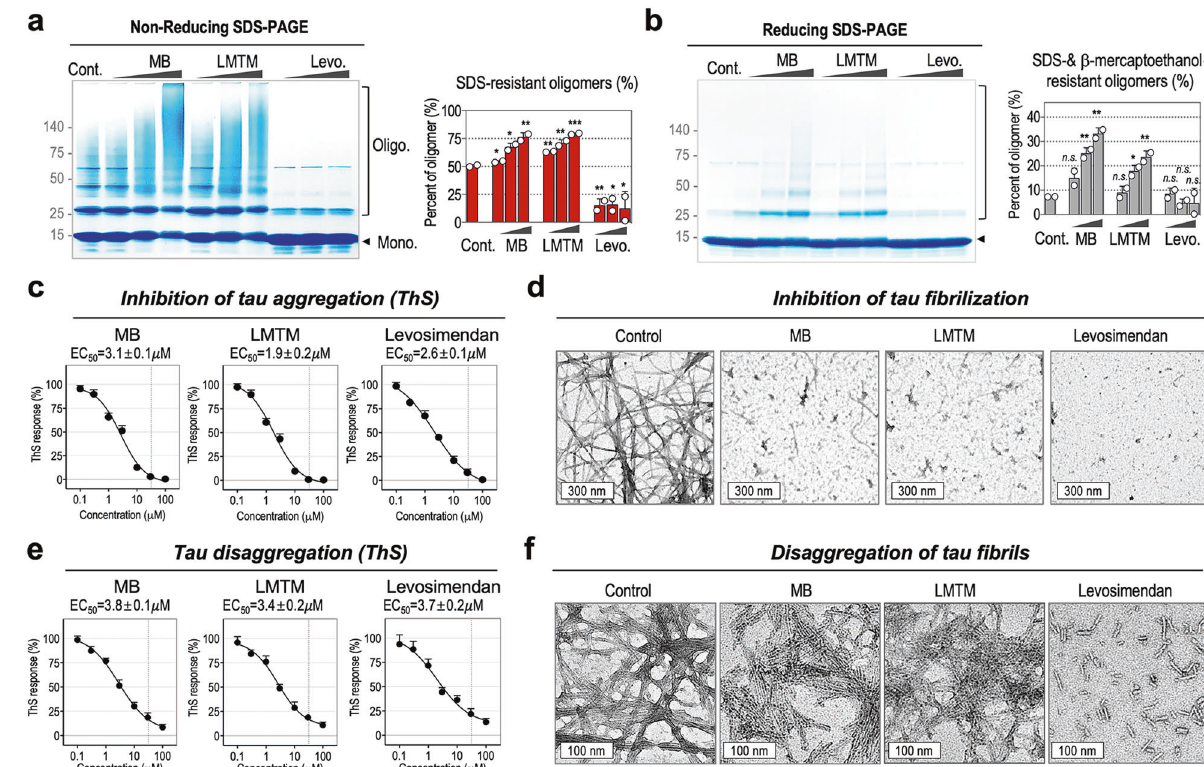
Fig. 3 Levosimendan inhibits disul fi de-dependent tau oligomerization in vitro. Nonreducing ( a ) and reducing ( b ) SDS ‒ PAGE analysis of tau oligomerization in vitro. Tau preaggregates were incubated with MB, LMTM, or levosimendan (10, 30, 100 µM) for 5 h at RT, and tau proteins were separated on an SDS ‒ PAGE gel (4 – 20%) under reducing or nonreducing conditions. Tau oligomers on SDS ‒ PAGE gels were visualized with Coomassie blue staining. The black arrow indicates the tau monomer (14 kDa). Bands above 25 kDa indicate tau oligomers. Relative amounts of tau monomers and oligomers were quanti fi ed by ImageJ. The percentages of SDS-resistant tau oligomers are indicated as red bars ( a ), and the percentages of SDS- and β -mercaptoethanol-resistant oligomers are indicated as gray bars ( b ). Data represent the mean ± S.D. of two independent experiments. n.s. nonsigni fi cant, *p < 0.05 , **p < 0.01 , ***p < 0.001, compared with control. c EC 50 curves of MB, LMTM, or levosimendan in inhibiting tau aggregation. TauK18 aggregation was induced by heparin and DTT in the presence of each drug for 5 days. The level of β -sheet aggregation was determined with thio fl avin S (ThS). Data represent the mean ± S.D. of three independent experiments. Prism ’ s nonlinear regression analysis was used to measure the EC 50 values. d Representative transmission electron microscopy images indicating the inhibitory effect of MB, LMTM, and levosimendan at 30 µM. Scale bar, 300 nm. e EC 50 curves of MB, LMTM, or levosimendan on disaggregating tau fi laments. For the disaggregation assay, tau aggregates were incubated with each drug at various concentrations for 4 days. The level of β -sheet aggregation was determined with thio fl avin S (ThS). Prism ’ s nonlinear regression analysis was used to measure the EC 50 values. Data represent the mean ± S.D. of three independent experiments. f Representative images of transmission electron microscopy indicating the drug ’ s effects on tau disaggregation at 30 µM. Scale bar, 100 8.8 ± 2.0 nm were observed in the levosimendan-treated mixture bond with cysteine. To verify its covalent modi fi cation to tau, one ( n = 69), supporting the disassembly of tau oligomers by of two nitrile groups of levosimendan was labeled with a 14 C-radioisotope (Fig. 4a and Supplementary Materials). 14 C-levosimendan was administered to tau preaggregates that contained disul fi de-linked tau oligomers for 2 h. Then, disul fi de- linked tau oligomers were separated on a nonreducing SDS ‒ PAGE gel (Fig. 4b, c). 14 C-radiography showed tau monomers and dimers labeled with 14 C-levosimendan, indicating its covalent attachment to tau (Fig. 4c). Then, the relative intensities of the Coomassie blue-stained bands of the monomer, dimer, trimer, and tetramer were compared (Fig. 4c, d). Corresponding to Fig. 3e, treatment with 14 C-levosimendan disassembled disul fi de-linked tau oligo- mers, increased the level of monomers as levosimendan did (Fig. 4c, d). In addition, high-resolution TEM images were acquired to validate the size of tau oligomers in the DMSO-treated control and levosimendan-treated mixture. Heterogeneous tau particles with diameters of 13.7 ± 5.2 nm were observed in the DMSO-treated control ( n = 60) (Fig. 4e, f). The diameters of tauK18 oligomers match those in a previous report showing that tauK18 formed spherical tau oligomers with diameters of 10 – 20 nm 54 . In evaluate the reversibility of the reaction, the reaction mixture was diluted ten times. Upon dilution, cysteine dissociation comparison, comparably small tau particles with diameters of